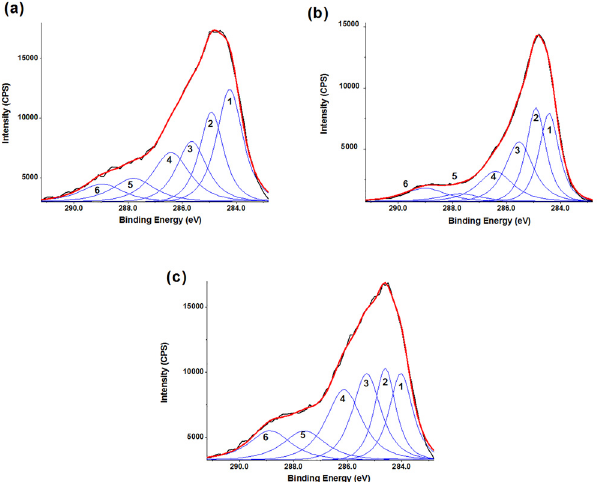
Fig 7. C 1s XPS spectra of freeze-dried flocs by AlCl 3 and PACl coagulation. (a) AlCl 3 , pH 5.0; (b) PACl, pH 5.0; (c) PACl, pH 6.0. Coagulants dose: 0.8 mg Al/mg DOC, peak numbers correspond to the carbons mentioned in the